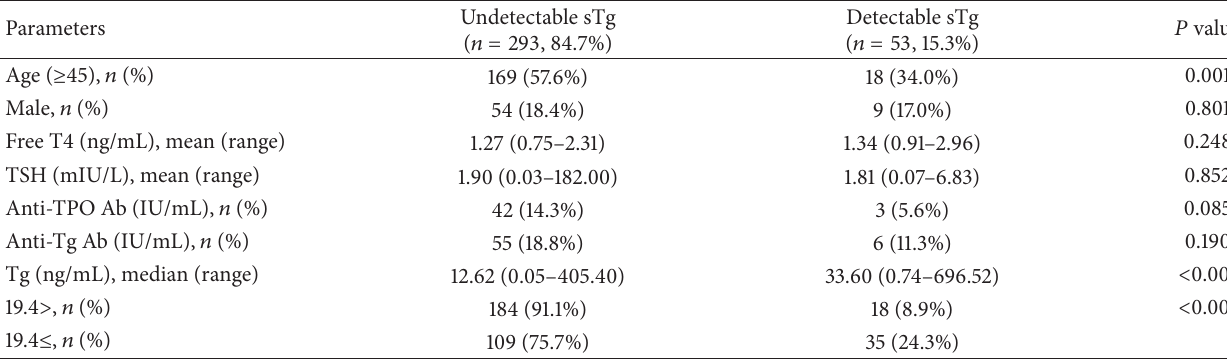
Table 2: Preoperative factors for predicting detectable sTg in the 1-year follow-up.